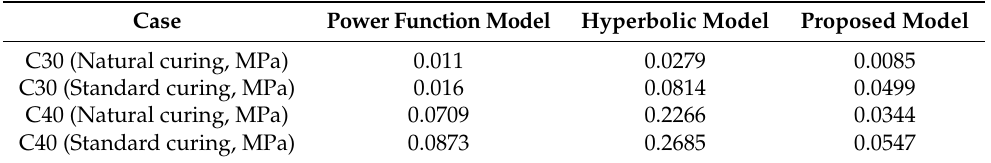
Table 2. The total fitting standard deviations of the three prediction models.